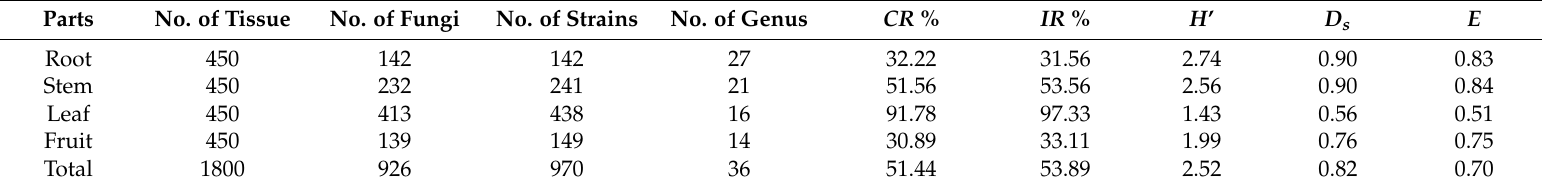
Table 2. The Index of endophytic fungi flora diversity of Litsea cubeba (Lour.) Pers.